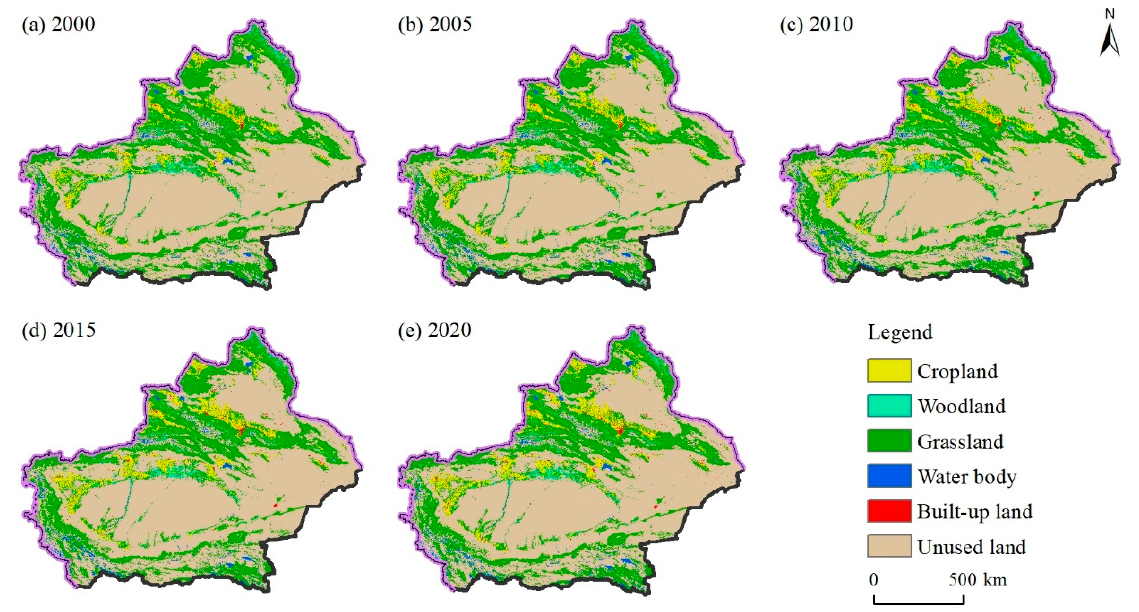
Figure 2. Land use types and spatial distribution in Xinjiang: ( a ) land use in 2000; ( b ) land use in 2005; ( c ) land use in 2010; ( d ) land use in 2015; and ( e ) land use in 2020.